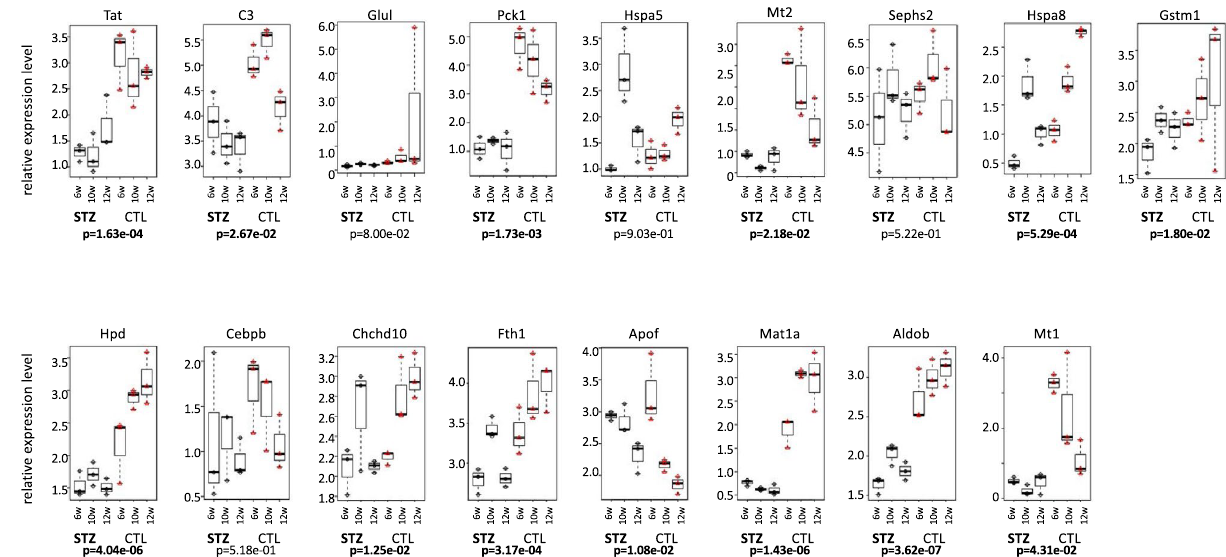
Figure 3. Expression pattern of target genes candidates of miRNAs with different expression in STZ-mice and in CTL-mice. The expression of 17 genes from the liver samples that were serially collected is shown. Statistical analysis was performed using the student-t test, and a difference was considered statistically significant for a p < 0.05 (bold letter). The vertical axis represents the expression level of